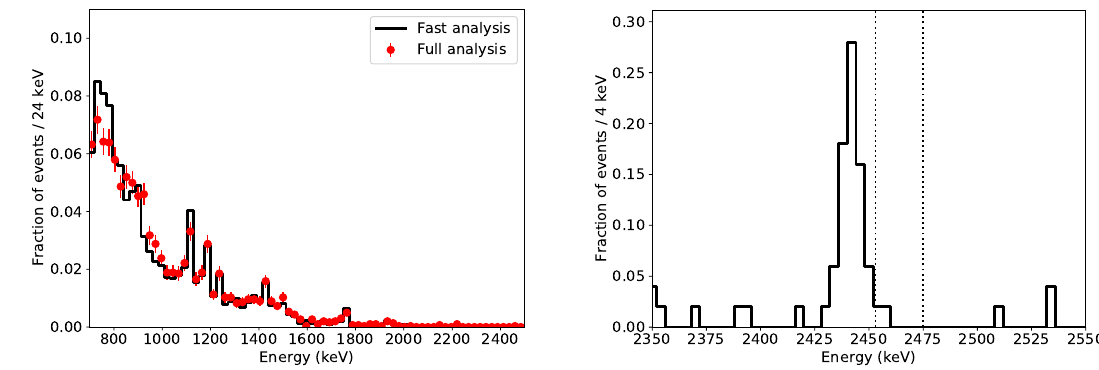
Figure 10 . Distributions of reconstructed event energy for cathode 214 Bi simulated decays. Left panel: simulated events in NEXT-White at 15 bar and passing all 2 (cid:23)(cid:12)(cid:12) cuts. The black histograms show the expectations from the fast analysis, the red markers from the full analysis. Right panel: simulated events in NEXT-100 at 15 bar and passing all 0 (cid:23)(cid:12)(cid:12) fast analysis cuts except the energy ROI one, indicated by the vertical dashed lines. All curves are unit-area